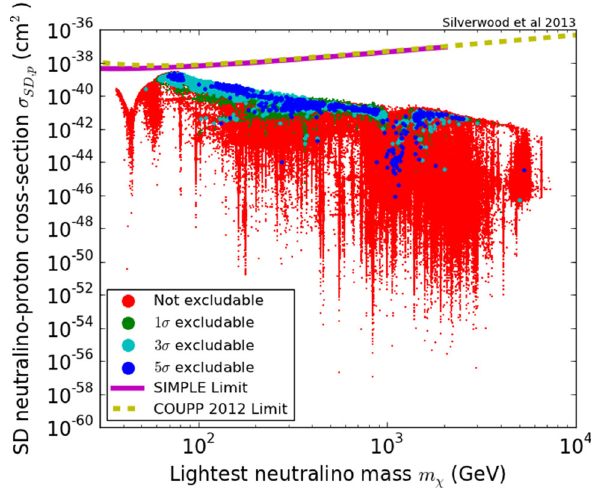
Fig. 26 Spin-dependent WIMP-proton scattering cross section, σ SD χ − p as a function of WIMP mass for points derived from explorations of the MSSM-25 parameter space. The corresponding 90% CL limits from SIMPLE[244]andCOUPP[245]directdetectionexperimentareshown as magenta and yellow lines respectively. Colour coding indicates pre- dicted IceCube-86 model exclusion levels. The areas of cyan and blue points show that IceCube-86 has the ability to exclude models beyond the reach of current direct detection experiments. Figure from [246] (Copyright SISSA Medialab Srl. Reproduced by permission of IOP Publishing. All rights reserved)